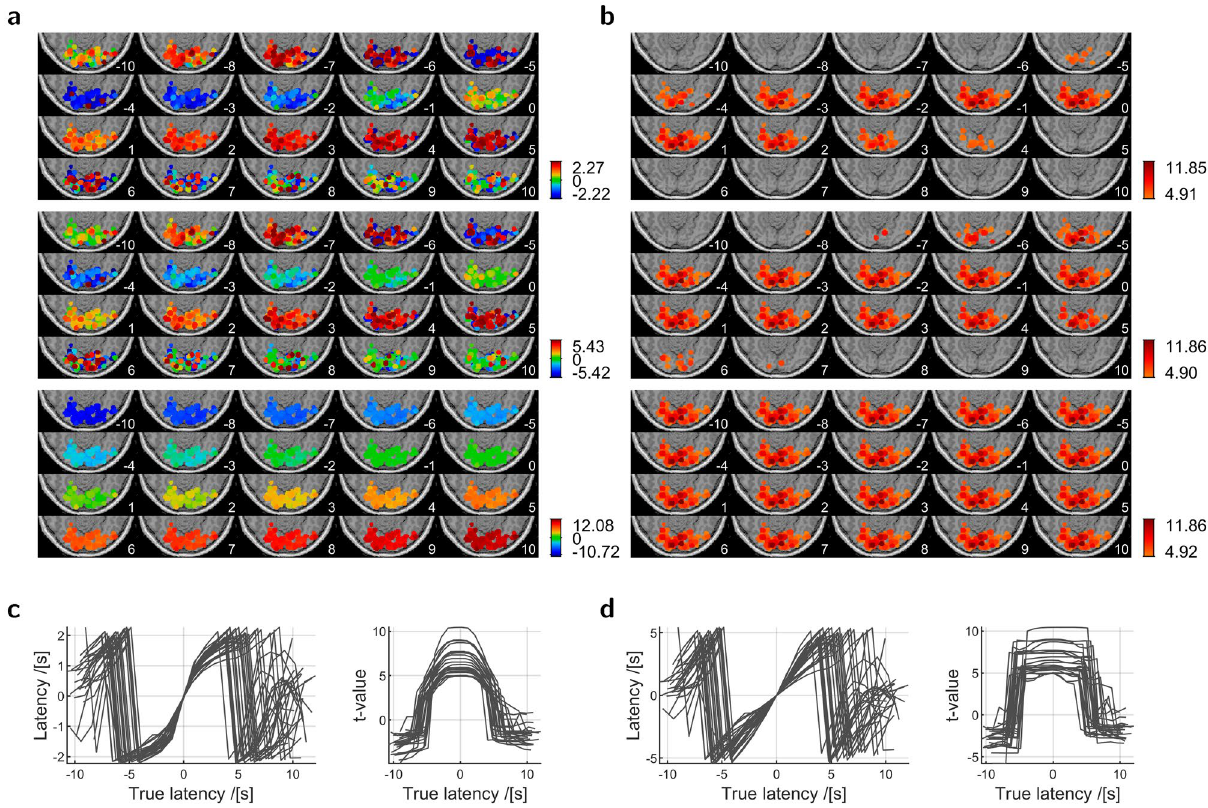
Figure 6. Retrieval of known response latencies. Modeled stimulus onset times were shifted within [−10, 10] s in steps of 1 s in the voxels of the bottom left slice of Fig. 4 that had insignificant optimized latency between −0.72 and 2.08 s and signal-to-noise ratio between 0.34 and 0.84. Negative onset shift moved the modelled HRF to earlier time, thus introduced an additional positive response latency in a voxel time course. Because latency is a difference between true and modeled responses, it persists in another frame where the onset is left untouched and the voxel time course is shifted to later time. Numbers indicate introduced shift in seconds. ( a ) Maps of retrieved latency. Top , Time derivative with ratio–latency function from distorted HRF 15 with latency limits of ±2.2 s, Middle , Time derivative with ratio–latency function from shifted HRF, Fig. 1f D6, with limits of ±5.5 s, Bottom , Optimization, ( b ) Maps of t-value of estimated magnitude above a significance level of p < 0.05 Bonferroni corrected, ( c ) Latency and t-value as functions of known latency in 30 randomly selected voxels, using the ratio–latency function from distorted HRF. Retrieved latencies are squeezed versions of the true latencies; a known latency of 5 s is retrieved as a latency of 2 s, ( d ) As ( c ), using the ratio–latency function from shifted